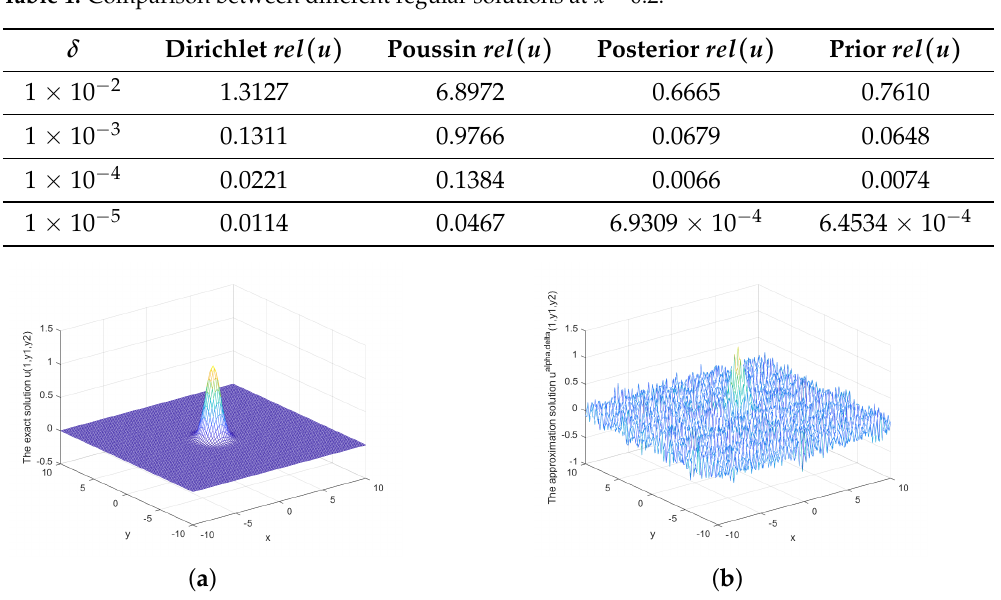
Figure 1. ( a ) The exact solution and ( b ) the regularized solution when x = 0.2, δ = 1 × 10 − 2 under prior